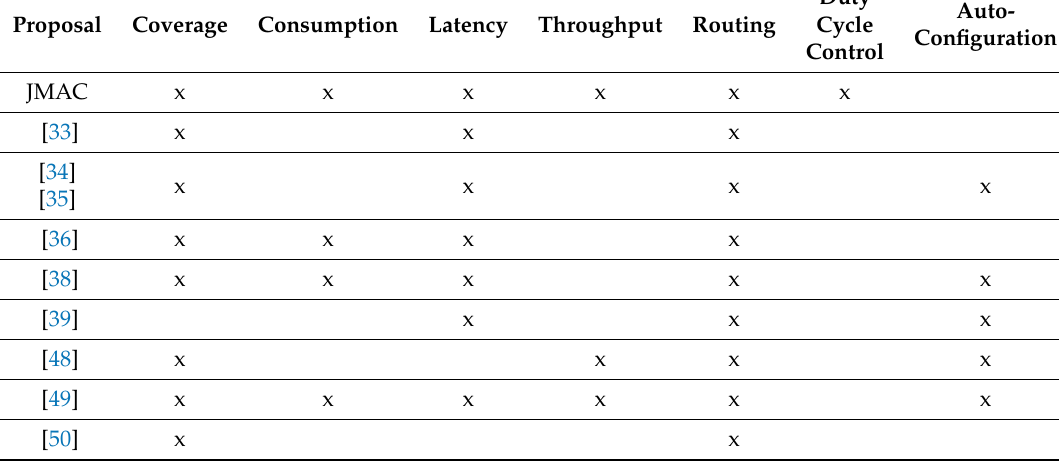
Table 4. Comparison of addressed topics in JMAC and other releveant LoRa multi-hop protocols.